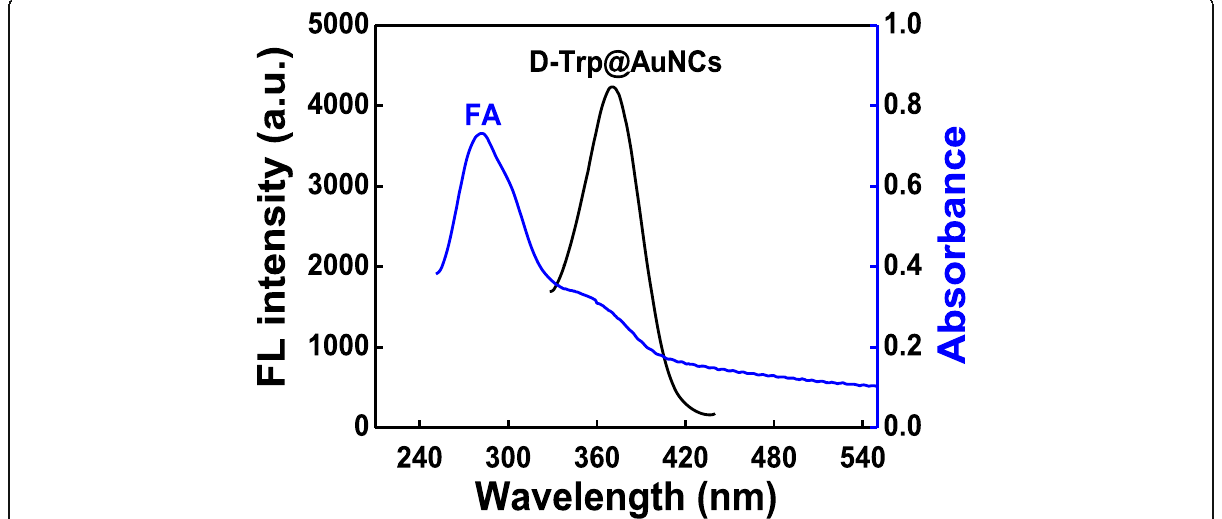
Fig. 3 UV-vis absorption spectra of FA and the fluorescence excitation spectrum of D